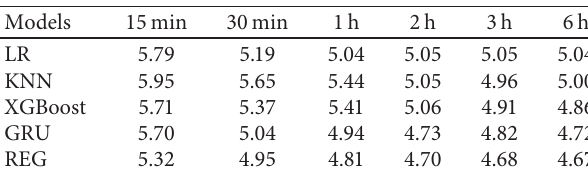
Figure 19: Regression integration prediction results when the time step is 6 h. Table 5: Multimodel MAE comparison table for different step sizes.